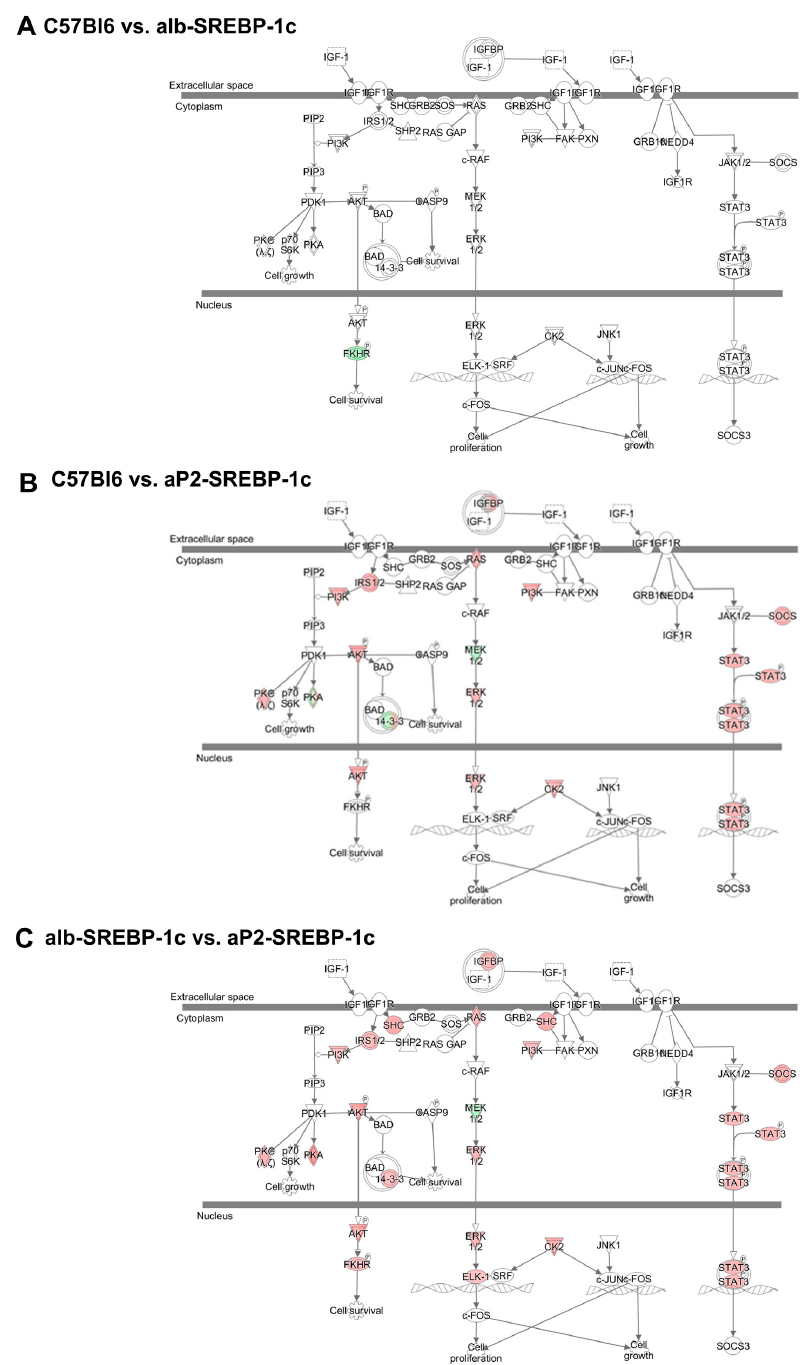
Figure 1. Differential activation of downstream molecules of the insulin-like growth factor (IGF) signaling network. Genes with differential gene expression (1.5-fold, p -value < 0.05) were used for IPA ® core analyses. Different abundance of genes in comparison to hepatic gene expression of ( A ) C57Bl6 vs. alb-SREBP-1c, ( B ) C57Bl6 vs. aP2-SREBP-1c, and ( C ) alb-SREBP-1c vs. aP2-SREBP-1c liver tissue was overlaid to the canonical IGF signaling pathway. Color code: red—increase in C57Bl6 ( A , B ) and alb-SREBP-1c ( C ), green—decrease in C57Bl6 ( A , B ) and alb-SREBP-1c ( C ) based on measured expression differences.